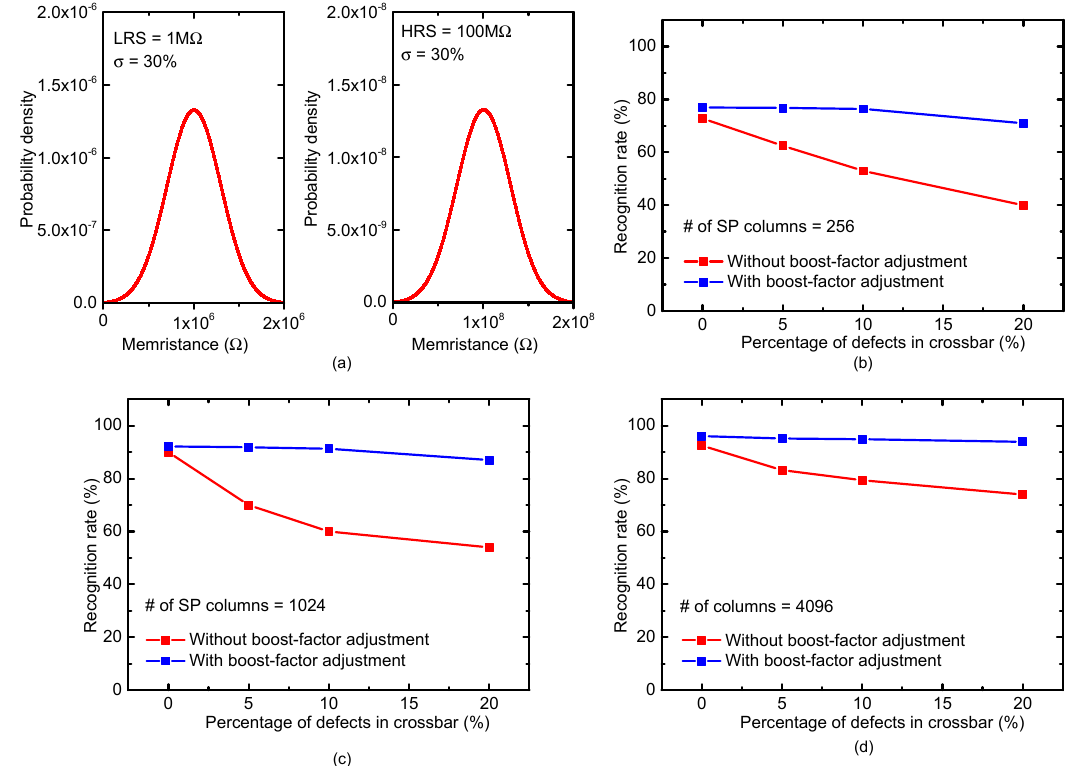
Figure 9. ( a ) The statistical distributions of LRS and HRS with the percentage σ of memristance variation = 30% in the simulation; ( b ) the MNIST recognition rate of the non-ideal crossbar with 256 SP columns and the percentage σ of memristance variation = 30%. Here, SP means Spatial Pooler.; ( c ) the MNIST recognition rate of the non-ideal crossbar with 1024 SP columns and the percentage σ of memristance variation = 30%; and ( d ) the MNIST recognition rate of the non-ideal crossbar with 4096 SP columns and the percentage σ of memristance variation =